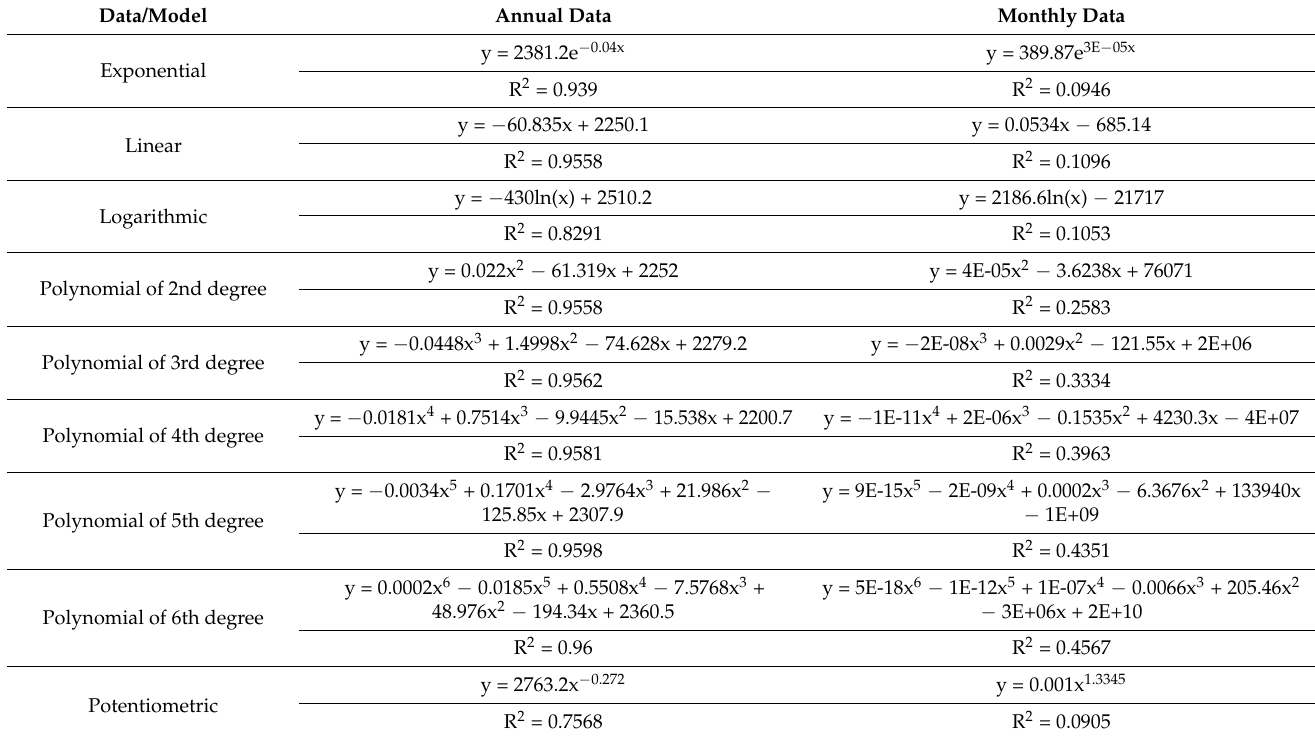
Table A16. Trend models for the West Pomeranian